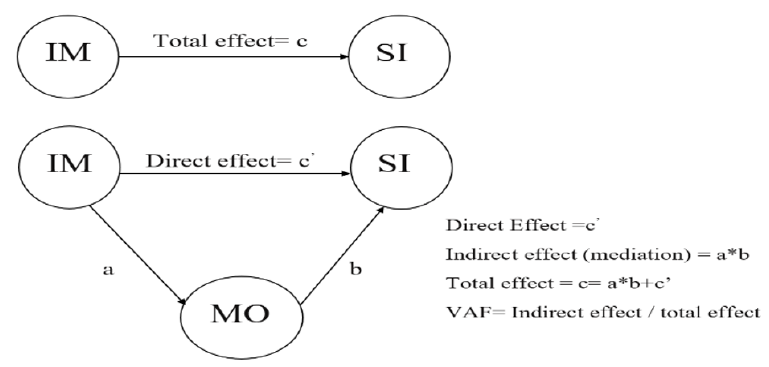
Figure 3. Mediation effect of Motivation (MO).